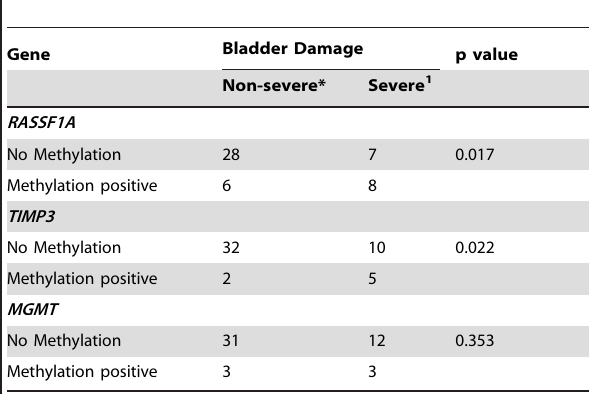
Table 2. Promoter methylation status of RASSF1A, TIMP3